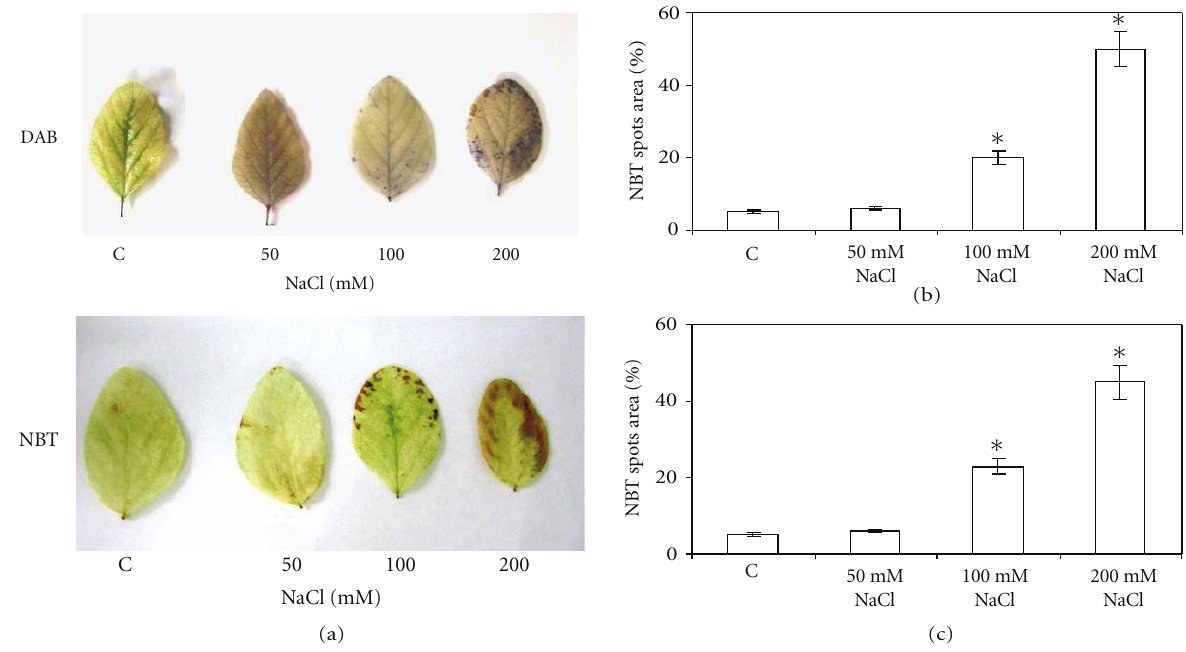
Figure 1: Histochemical detection of H 2 O 2 and O 2 •− in soybean leaves treated with di ff erent NaCl concentrations. The second pair of fully expanded leaves upper the cotyledons were used for the assays as described in Experimental section. (a) Leaves from control and NaCl-treated plants stained for H 2 O 2 (DAB) and O 2 •− (NBT) content. The figure is representative of four di ff erent experiments. Hydrogen peroxide (b) and superoxide anion deposits (c) were quantified by measuring the number of pixels of spots using the NIH Image program (National Institutes of Health, USA). Results are expressed as percentage of spot area versus total leaf area. ∗ P < . 05 compared to control, according to Tukey’s multiple range test.